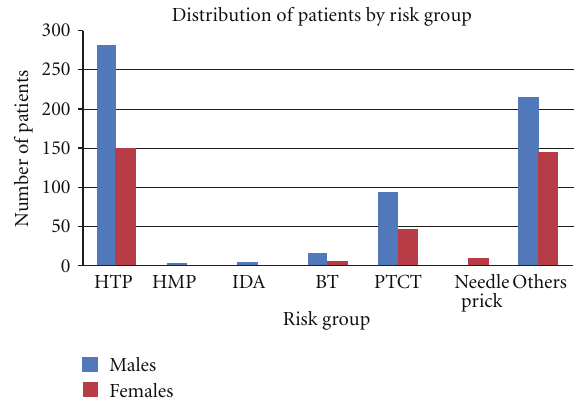
Figure 3: Distribution of the participants on the basis of their Risk Behavior: HTP-heterosexual promiscuous, HMP-Homosexual promiscuous, IDA-Injected Drug Abuse, BT-Blood Transfusion, PCTC-Parent to child transmission, and